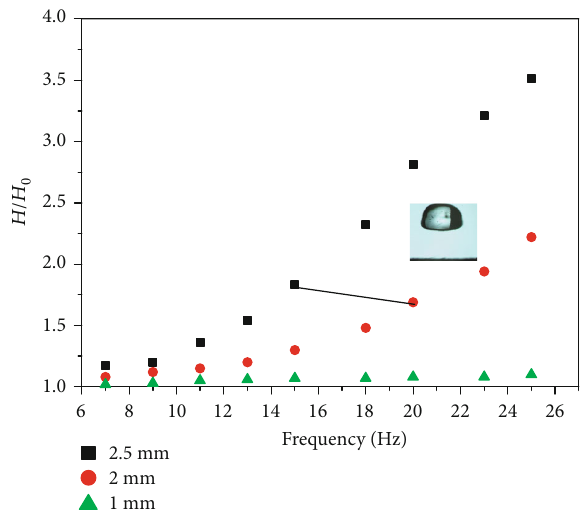
Figure 8: The maximum gradient of droplet height at di ff erent